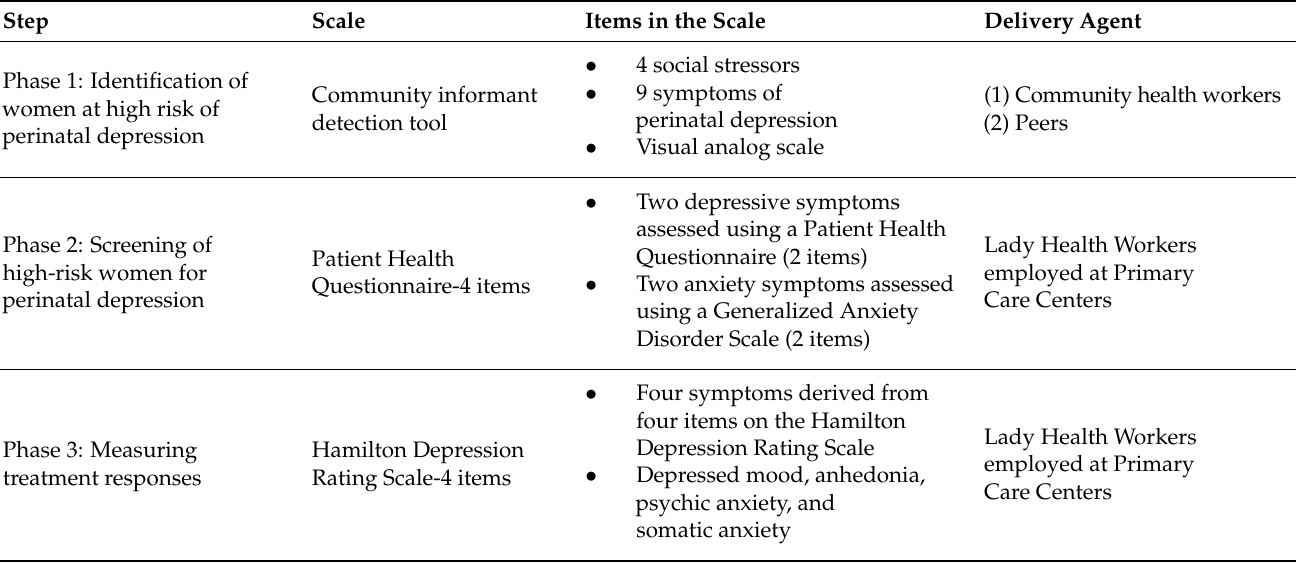
Figure 1. Approach for phased identification and screening for perinatal depression in Pakistan. Table 1. Proposed tools for screening and response monitoring for perinatal depression.